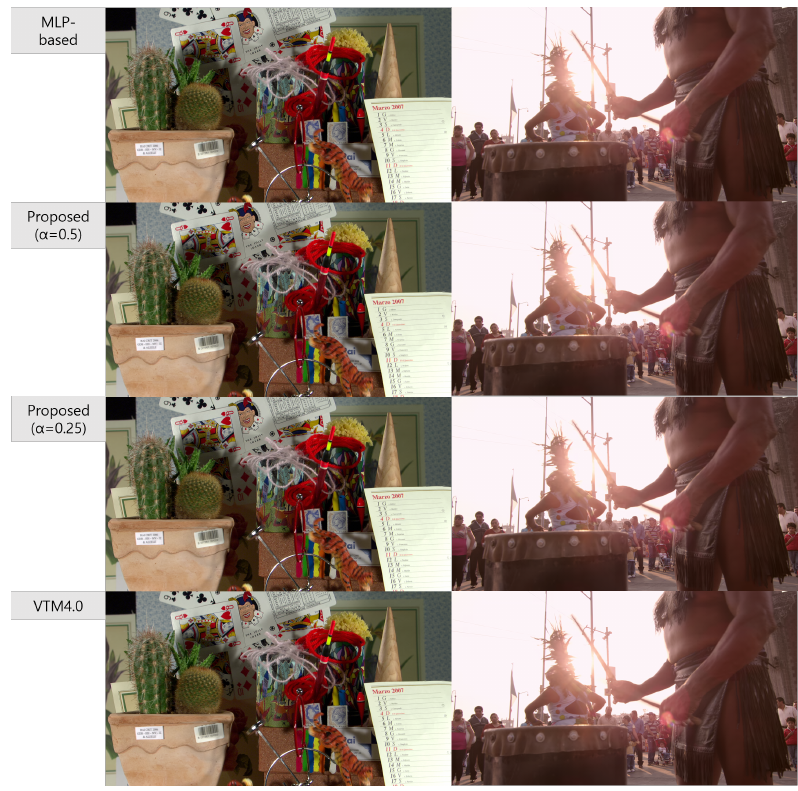
Figure 8. Decoded frames from Cactus and RitualDance videos yielding the worst ∆ EncT results presented in Table 8 when QP =